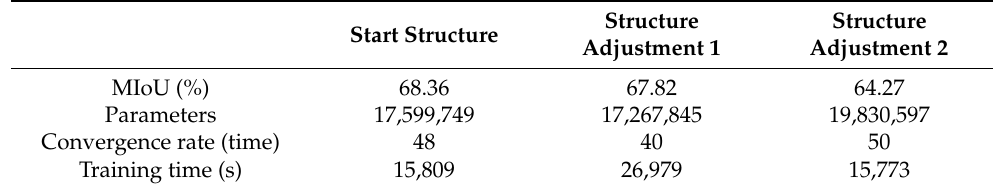
Table 4. Results of discriminator structure